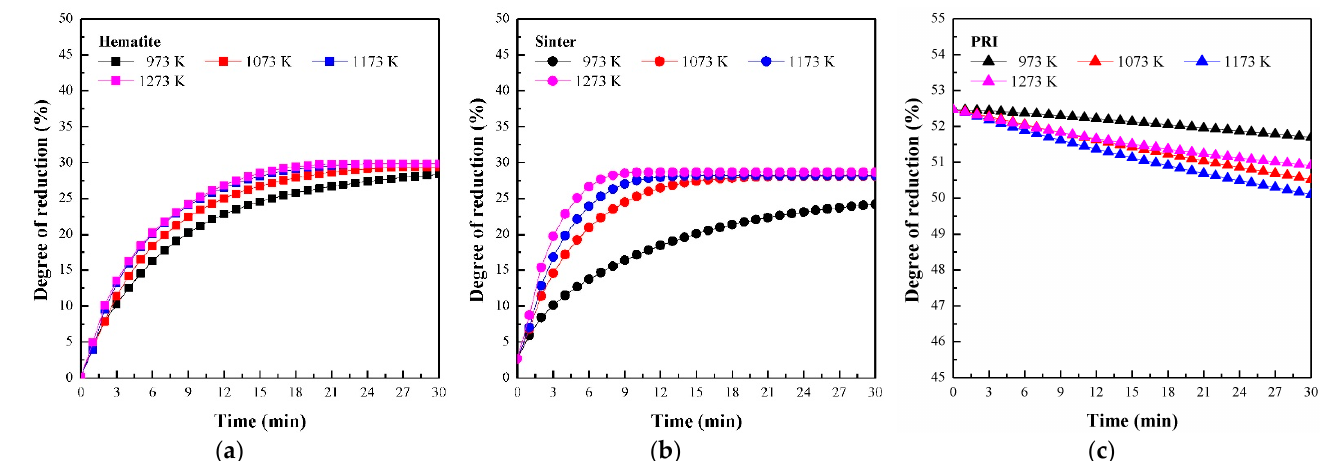
Figure 3. Reaction behaviour of ( a ) hematite, ( b ) sinter, and ( c ) PRI under the experimental conditions of Stage I.